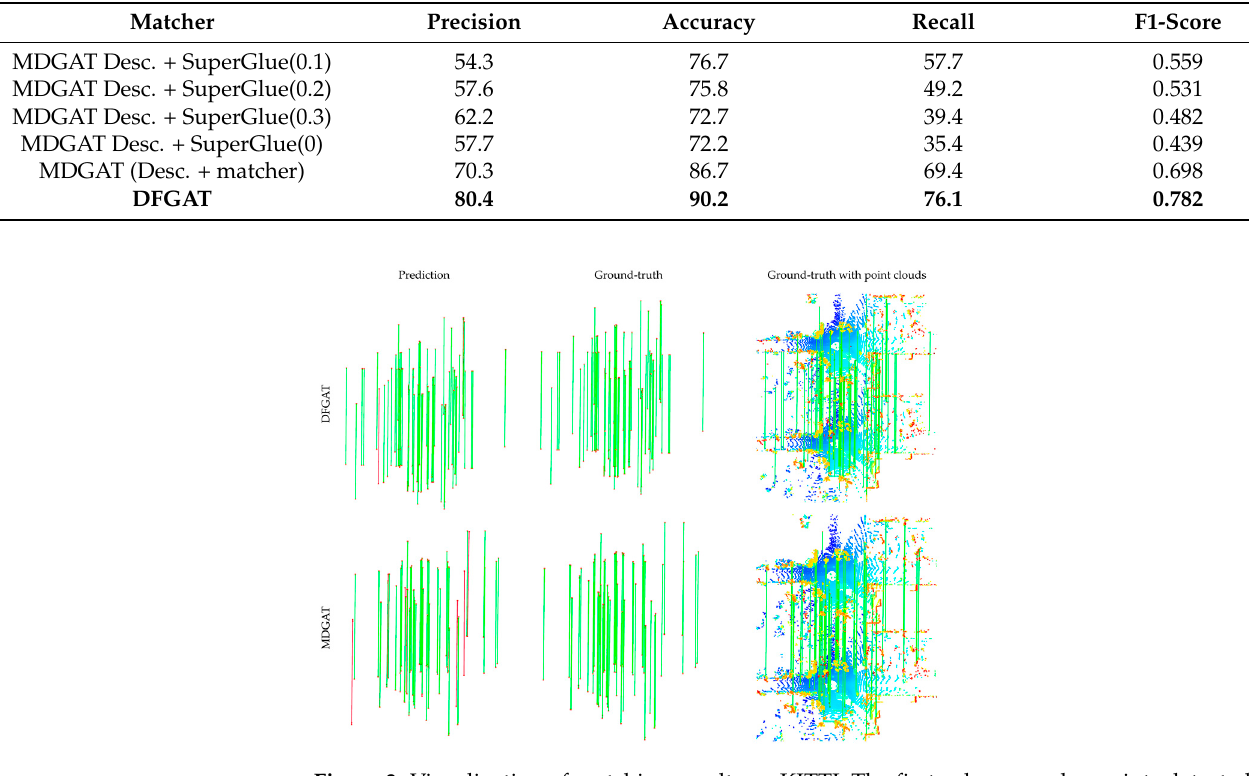
Figure 3. Visualization of matching results on KITTI. The first column are keypoints detected and matched using our method and MDGAT. The second column are ground-truth results without raw point clouds while the third column represents ground-truth results including raw point clouds. Our method performs better in terms of keypoints matching with more correct pairs (green) and fewer wrong pairs (red).